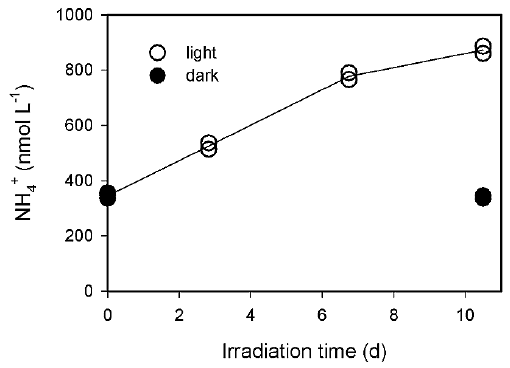
Fig. 2. NH + concentration as a function of irradiation time for the 4 sample collected in June 2009 from the mid-channel of the Macken- zie River off Inuvik, the Northwest Territory of Canada. The sample was exposed to full-spectrum irradiation. Line connects mean of du- plicates at each irradiation time